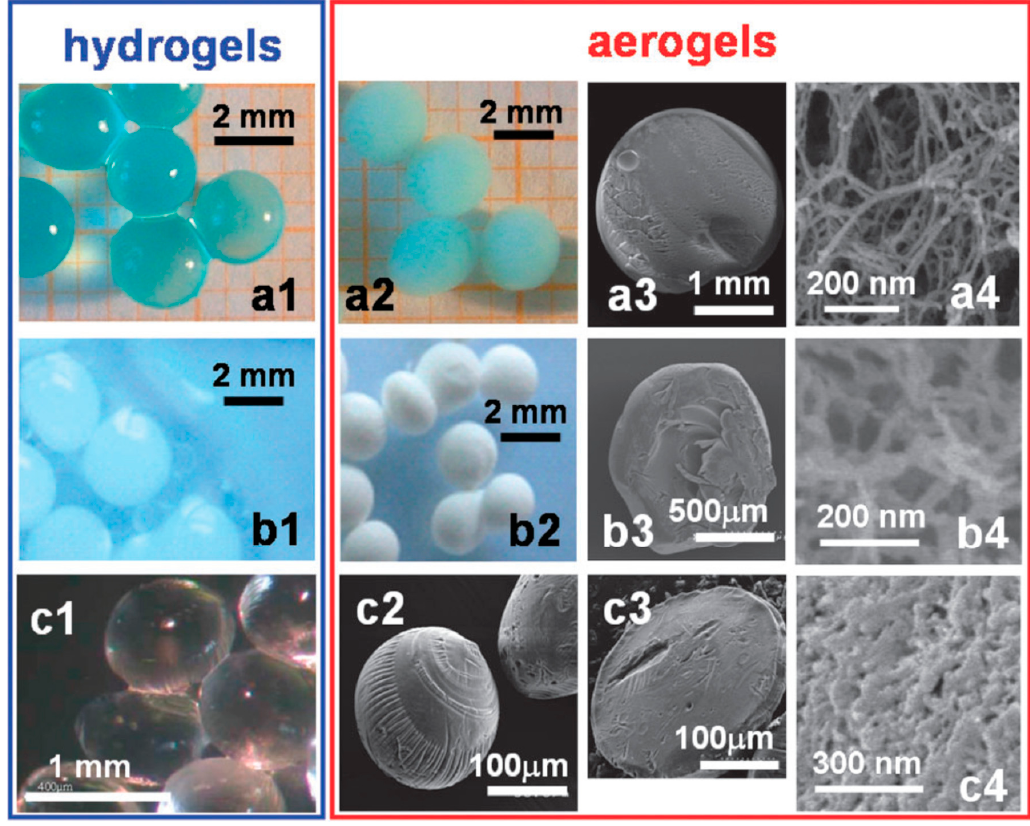
Figure 8. Optical and scanning electron microscopy (SEM) images of hydrogel state ( first column ) and aerogel spheres ( second column ) after drying and of cross-sections of aerogel spheres ( third and fourth columns ) of Cu-alginate ( row a ), chitosan ( row b ) and carrageenan ( row c ); reproduced with permission from reference [35].